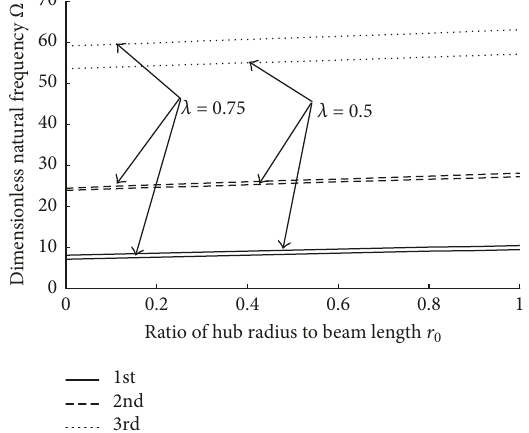
Figure 11: The first three-order dimensionless natural frequencies with ratios of hub radius to beam length for 𝜆 = 0.5 , 0.75 at 𝜔 = 5 , 𝑟 = 1/30 , and 𝛽 = 0.3 .